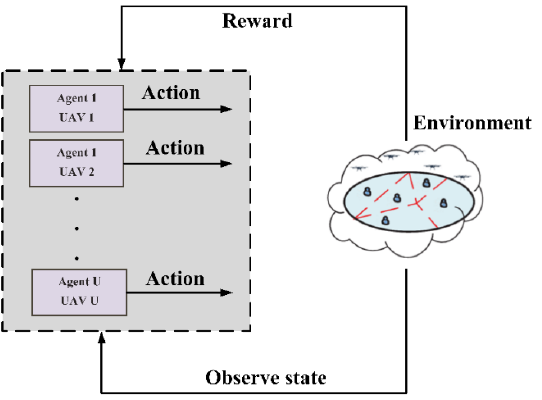
Figure 2. State, action, and environment relationship with an agent in the QL model in FANETs.